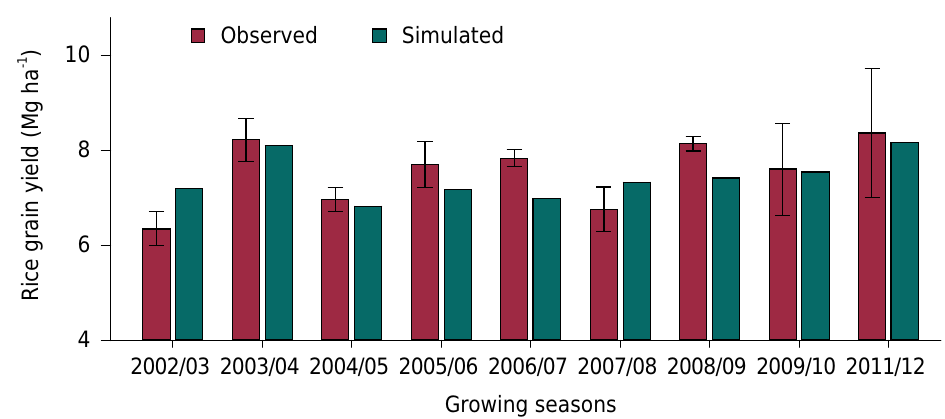
Figure 1. Observed and simulated rice grain yields under a no-tillage system in a long-term experiment in southern Brazil. Error bars represent standard deviations.